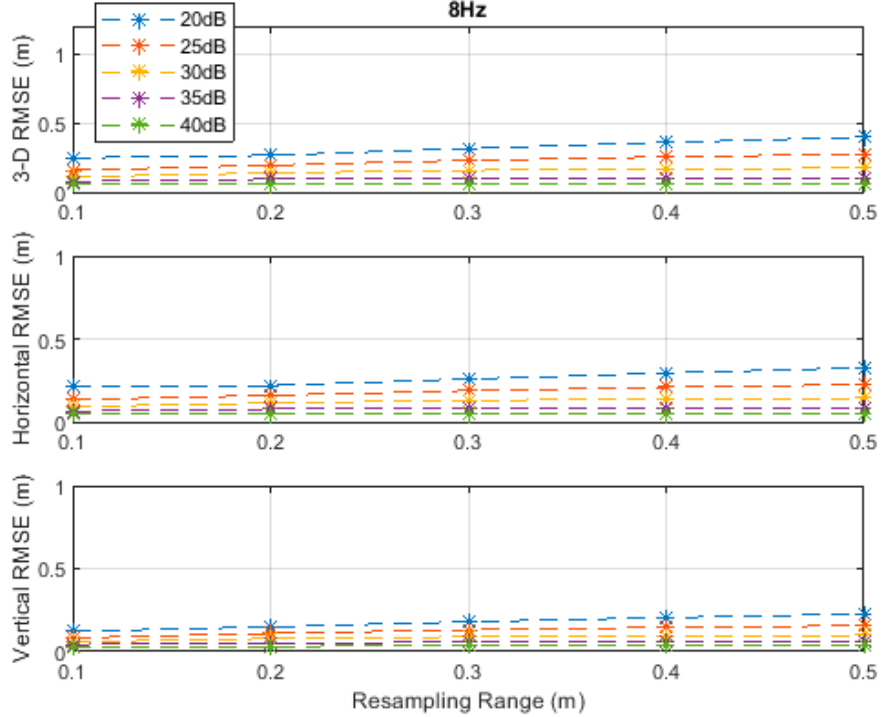
Figure 11. RMSE results along the horizontal circular path at a measurement update rate of 4 Hz.